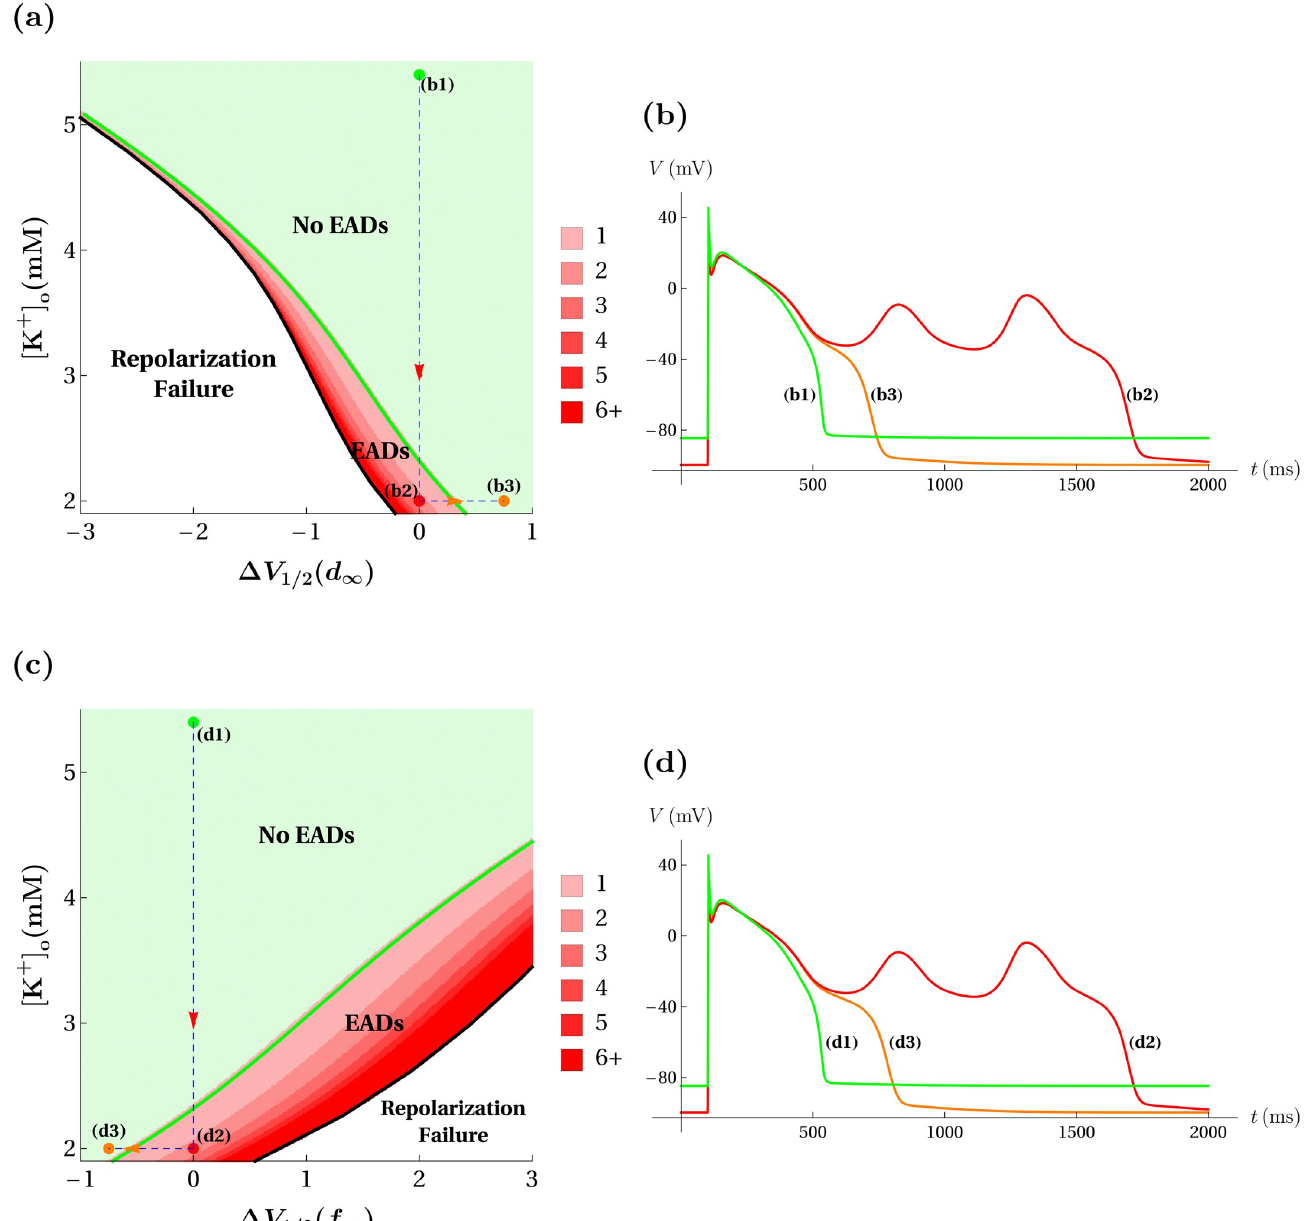
Fig 10. Narrowing the Ca 2+ current window by shifting d 1 ( V )or f 1 ( V )eliminates hypokalemia-induced EADs in the model. ( a )Model responsesin the ( Δ V 1/2 ( d 1 ), [K + ] o ) parameter plane. The green marker (b1) denotes the default condition, the red marker (b2) denotes the hypokalemia condition, and the orange marker (b3) denotes the d 1 ( V )-shiftedhypokalemia condition. ( b )Voltage time courses for the color-matched markers (b1), (b2), and (b3) of panel (a). ( c )Model responses in the ( Δ V 1/2 ( f 1 ), [K + ] o ) parameter plane. The green marker (d1) denotes the default condition, the red marker (d2) denotes the hypokalemia condition, and the orange marker (d3) denotes the f 1 ( V )-shiftedhypokalemia condition. ( d )Voltage time courses for the color-matched markers (d1), (d2), and (d3) of panel